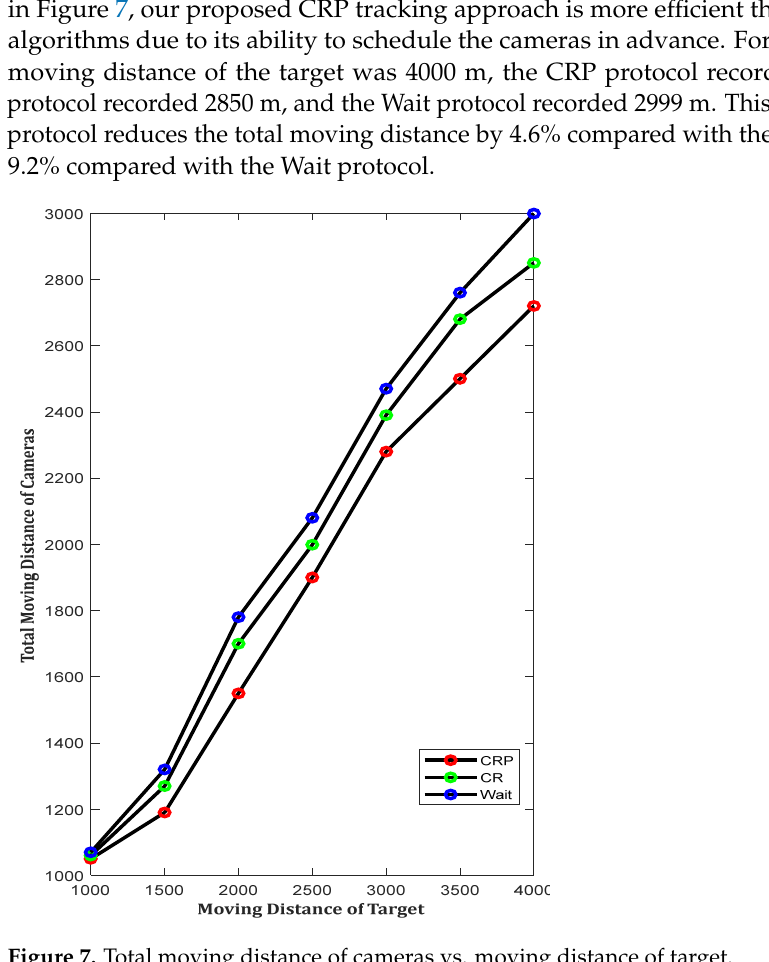
Figure 7. Total moving distance of cameras vs. moving distance of target.